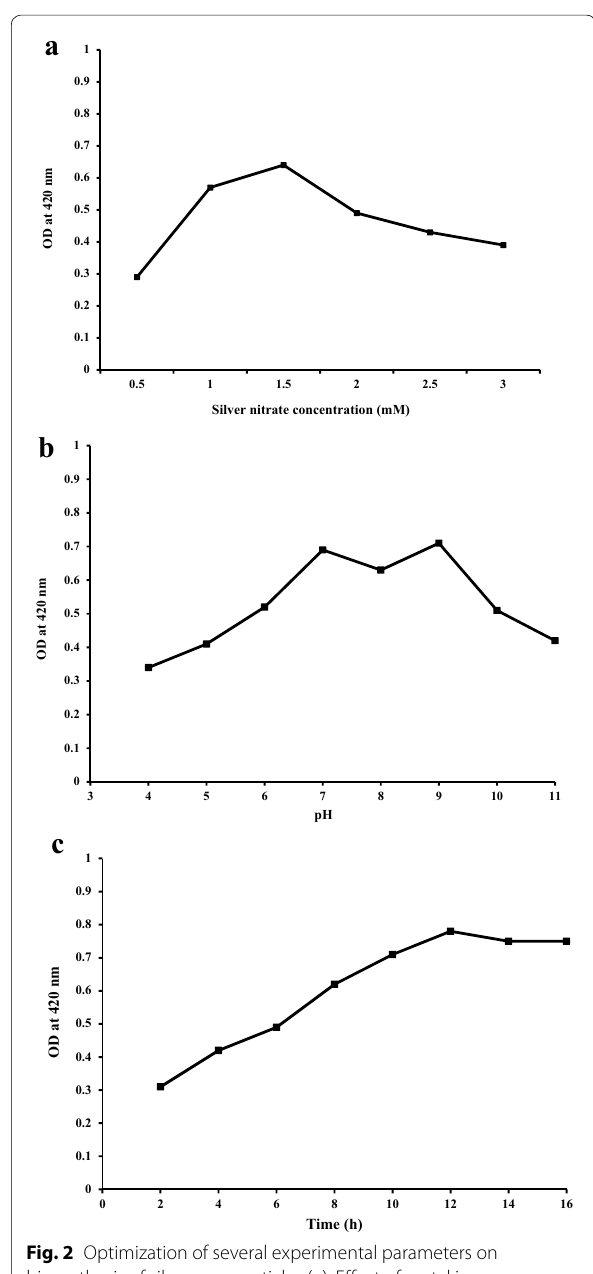
Fig. 2 Optimization of several experimental parameters on biosynthesis of silver nanoparticles ( a ). Effect of metal ion concentration on silver nanoparticle biosynthesis ( b ). Effect of pH on silver nanoparticle biosynthesis ( c ). Effect of time (incubation period) on silver nanoparticle